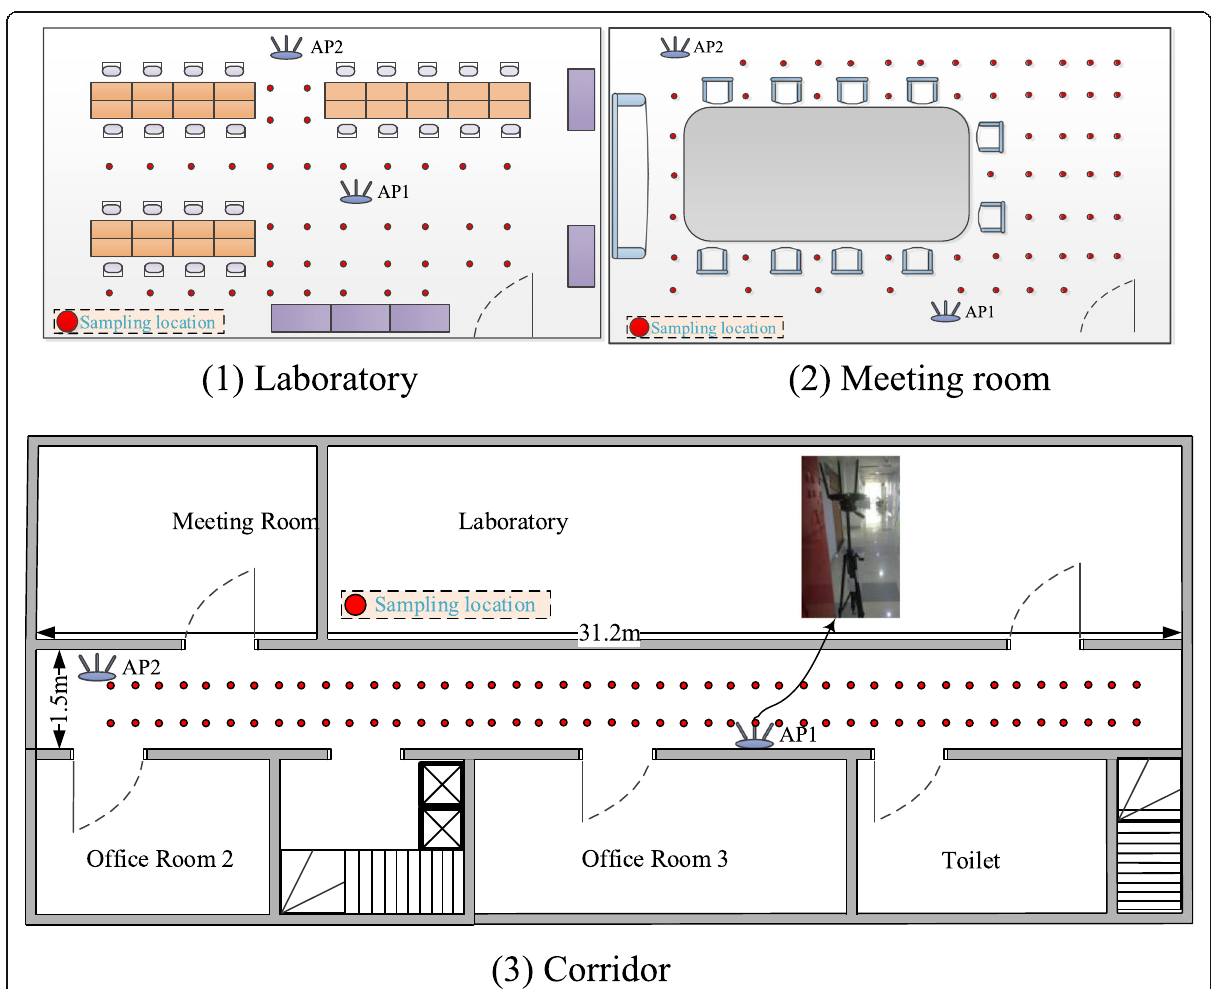
Fig. 6 Floor-plan of the three scenarios. The red points denote the sampling location. At each location, we collect 1000 packets from each